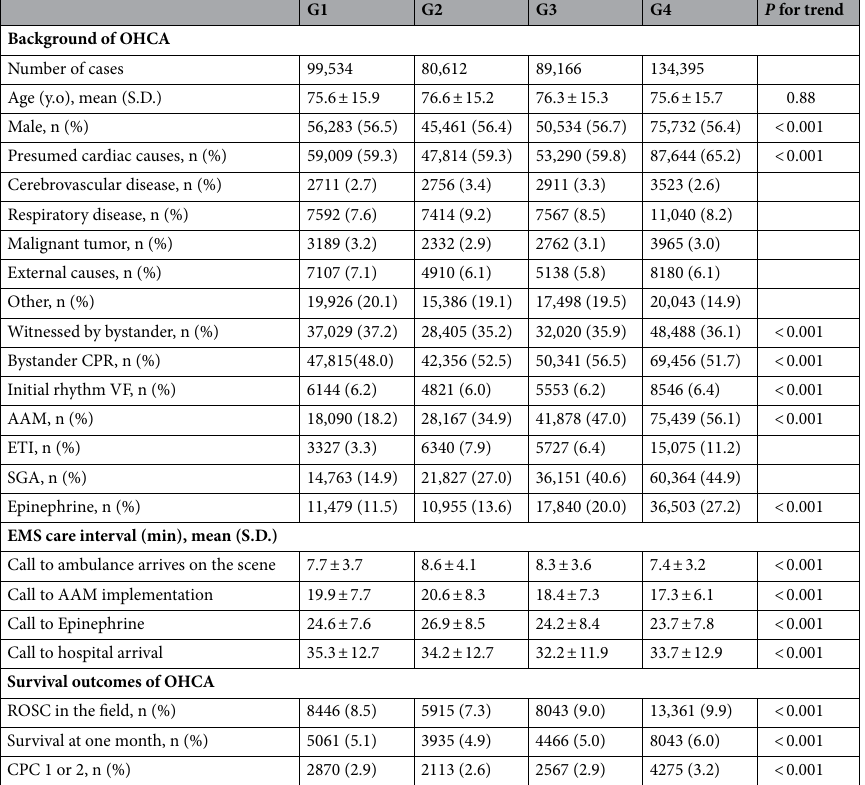
Table 1. Background of OHCA cases and OHCA survival outcomes grouped by the frequency of pre-hospital Advanced Airway Management approach (Quartile G1 to G4). OHCA Out-of-hospital cardiac arrest, CPR cardiopulmonary resuscitation, AAM advanced airway management, ETI endotracheal intubation, SGA supraglottic airway placement, EMS emergency medical service, ROSC return of spontaneous circulation, CPC the cerebral performance category.